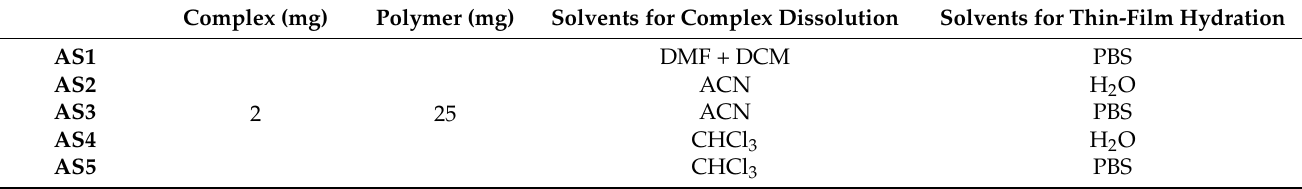
Table 1. Formulations used to optimize the formation of micelles loaded with [Au(cdc) 2 ] − . Complex